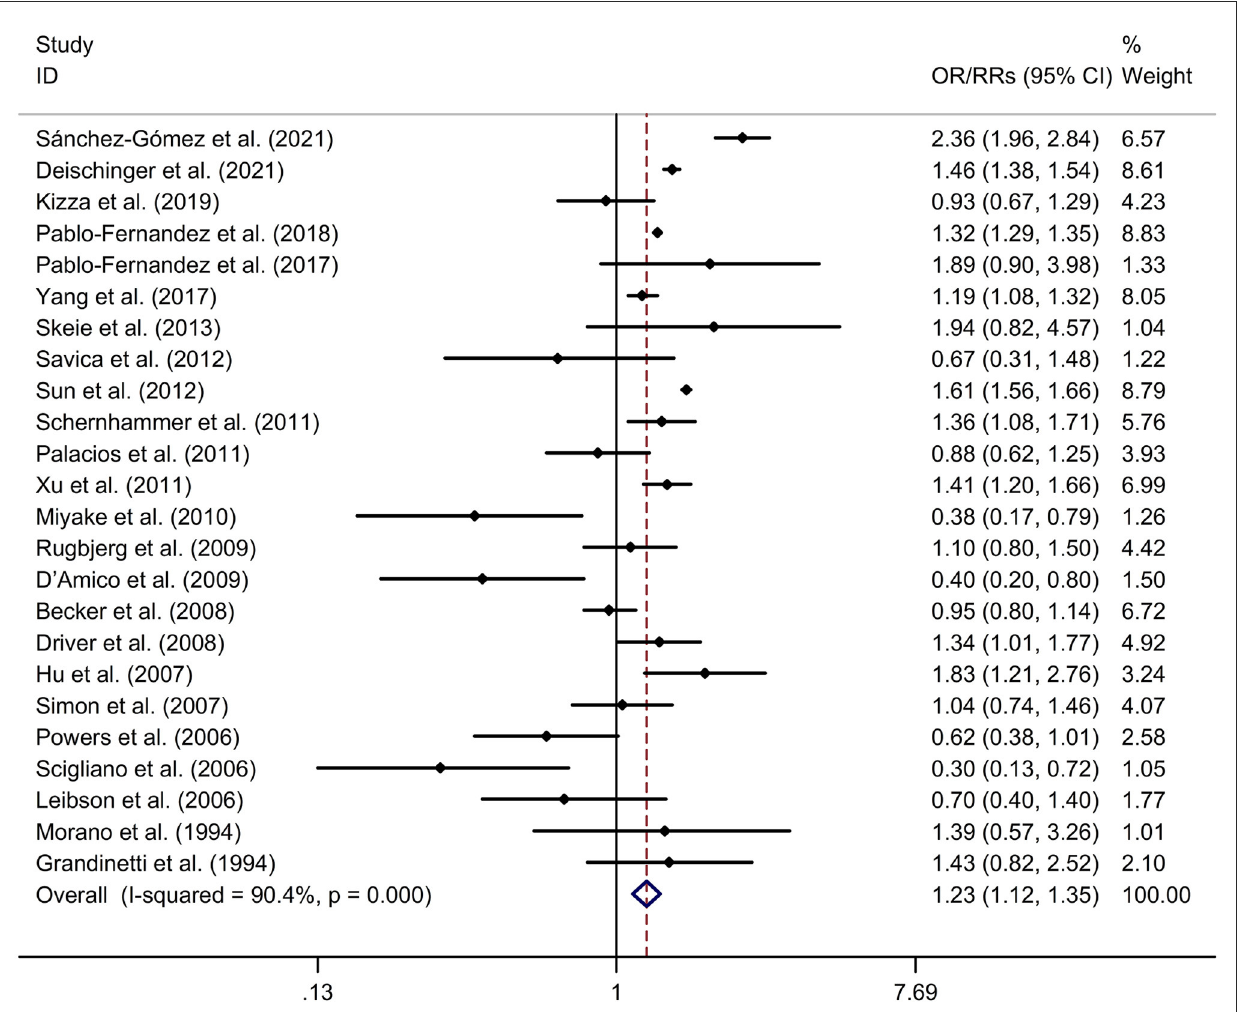
FIGURE2 Forest plot for association between DM and risk of PD. CI, confidence interval; DM, diabetes mellitus; OR, odds ratio; PD, Parkinson’s disease; RR, relative risk.